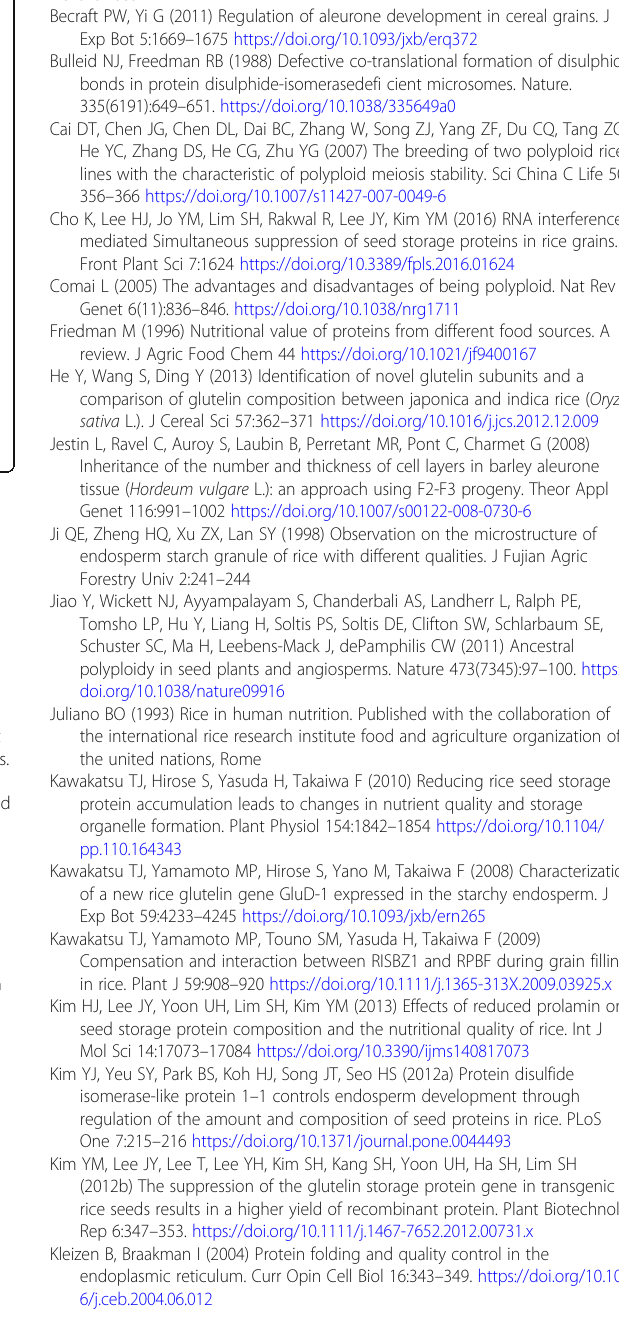
subunits, and prolamins are indicated by black vertical lines. Figure S3 . Variations in aleurone layer structural characterization in rice seeds with various ploidy levels. SEM images of aleurone layers and endosperms of 9311-2x and 9311-4x seeds at 17 and 25 DAF (harvested in 2018). Scale bar: 50 μ m. Figure S4. Variations in starchy endosperm structural characterization in rice seeds with various ploidy levels. SEM images of seed endosperms in two pairs of rice lines (9311-2x and 9311-4x, and A3- 2x and A3-4x, harvested in 2018) at 25 DAF. Scale bar: 10 μ m, 50 μ m and 500 μ m. Additional file 2: Table S1. Classification of rice glutelin genes. Table S2. Total protein content and average growth of tetraploid brown rice seeds and the corresponding diploid rice seeds harvested in Wuhan between November 2018 and November 2019. Data are presented as means ± standard errors of three biological replicates; * denotes significant differences in protein content between tetraploid and diploid rice ( p < 0.05); ** denotes extremely significant differences ( p < 0.01). Table S3. Glutelin and prolamin contents in tetraploid and diploid rice seeds (harvested in 2019). * denotes significant differences in component protein content between tetraploid and diploid rice ( p < 0.05); ** denotes extremely significant differences ( p < 0.01). Table S4. S eventeen amino acid contents of tetraploid and the corresponding diploid brown rice seeds (harvested in 2019). Data are presented means ± standard errors of three biological replicates; * denotes significant differences in amino acid contents between tetraploid and the corresponding diploid rice ( p < 0.05); ** denotes extremely significant differences ( p < 0.01). Table S5. Amylose contents of tetraploid and diploid rice (harvested in 2019). Data are presented as means ± standard errors of three biological replicates. * denotes significant differences in amylose contents between tetraploid and diploid rice ( p < 0.05). ** denotes extremely significant differences ( p <0.01). Table S6. Synthetic peptides for polyclonal anti-glutelin anti- bodies. Table S7. Primer sequences used for qRT-PCR. Additional file 3: Dataset S1. The list of all proteins identified using LC-MS/MS in 9311-4x and 9311-2x (harvested in